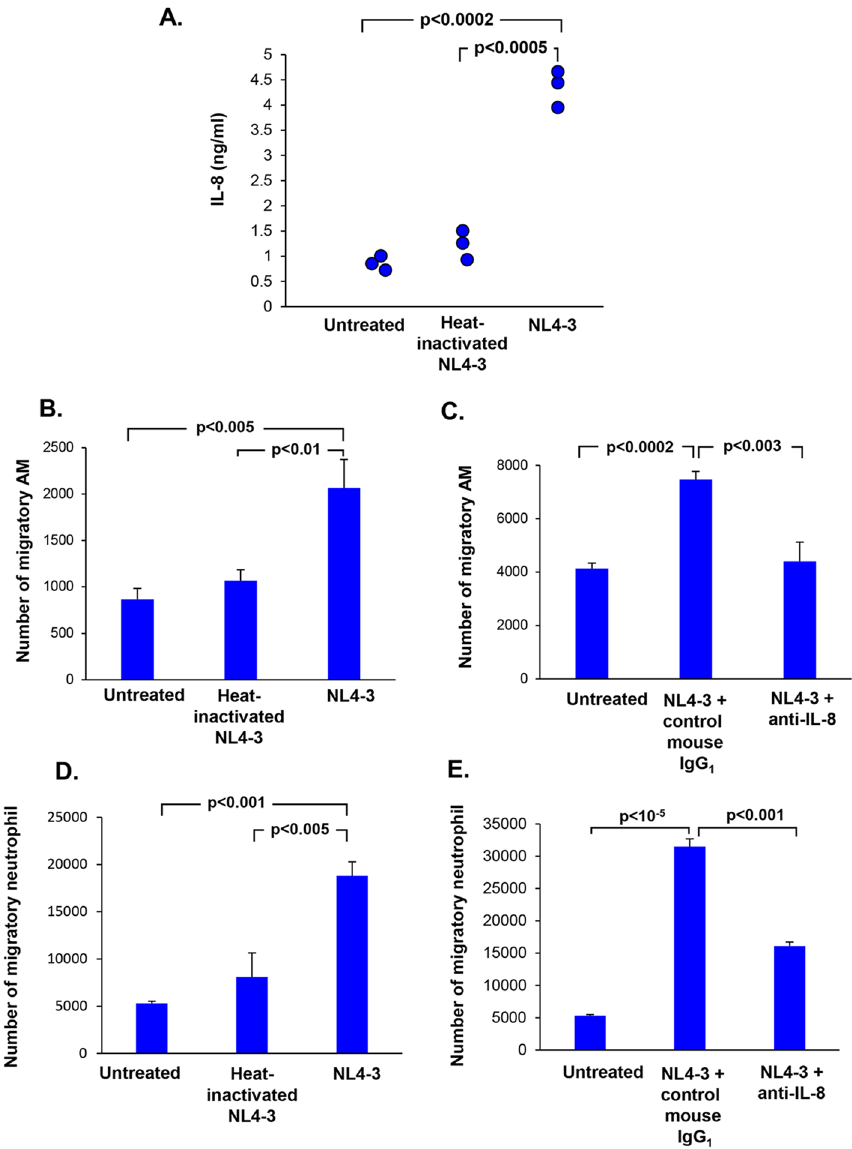
Figure 4. HIV-induced BC expression of IL-8 mediates AM and neutrophil migration. BC were exposed to HIV or heat-inactivated HIV for 2 days. ( A ) Quantification of IL-8 in culture supernatants of untreated, heat-inactivated HIV and HIV- treated BC cultures by ELISA. ( B ) HIV-induced BC release of these mediators induce migration of human alveolar macrophages and neutrophils. Alveolar macrophages obtained from an HIV negative normal subject were plated in serum-free medium in the upper chamber and incubated with BC-conditioned media from untreated, NL4-3 treated and heat-inactivated NL4-3-treated BC culture in the lower chamber of transwell system. The number of migratory cells were quantified after 3 h. ( C ) Migration of human alveolar macrophages mediated by BC-release of IL-8. BC-conditioned media were pre-treated with mouse IgG1 control or anti-IL-8 neutralizing antibody (both at 2 µg/ml) for 30 min prior to addition to the lower chamber. Human alveolar macrophages were plated on the upper chamber and incubated with conditioned media from untreated BC, HIV-BC pretreated with mouse IgG 1 -treated or HIV-BC pretreated with anti-IL-8 neutralizing antibody. The number of migratory alveolar macrophages were counted after 3 h. Data shown are the mean ± SD of one representative of three independent experiments performed in triplicate. ( D ) Stimulation of migration of neutrophils. Human neutrophils in serum-free RPMI were plated in the upper chamber and incubated with BC-conditioned media from untreated, HIV- treated and heat-inactivated HIV-treated BC culture in the lower chamber of transwell system. The number of migratory cells were quantified after 1 h of incubation. ( E ) Migration of human neutrophils mediated by BC-released IL-8 in conditioned media. BC-conditioned media were pre-treated with mouse IgG 1 control and anti-IL-8 neutralizing antibody (both at 2 µg/ml) for 30 min prior to addition to the lower chamber. Human neutrophils were plated on the upper chamber and incubated with conditioned media from untreated BC, HIV-BC pretreated with mouse IgG 1 -treated, HIV-BC pretreated with anti-IL-8 neutralizing antibody or HIV-treated BC. The number of migratory alveolar macrophages were counted after 1 h of incubation. Data are presented as mean ± SD of one representative of three independent experiments performed in